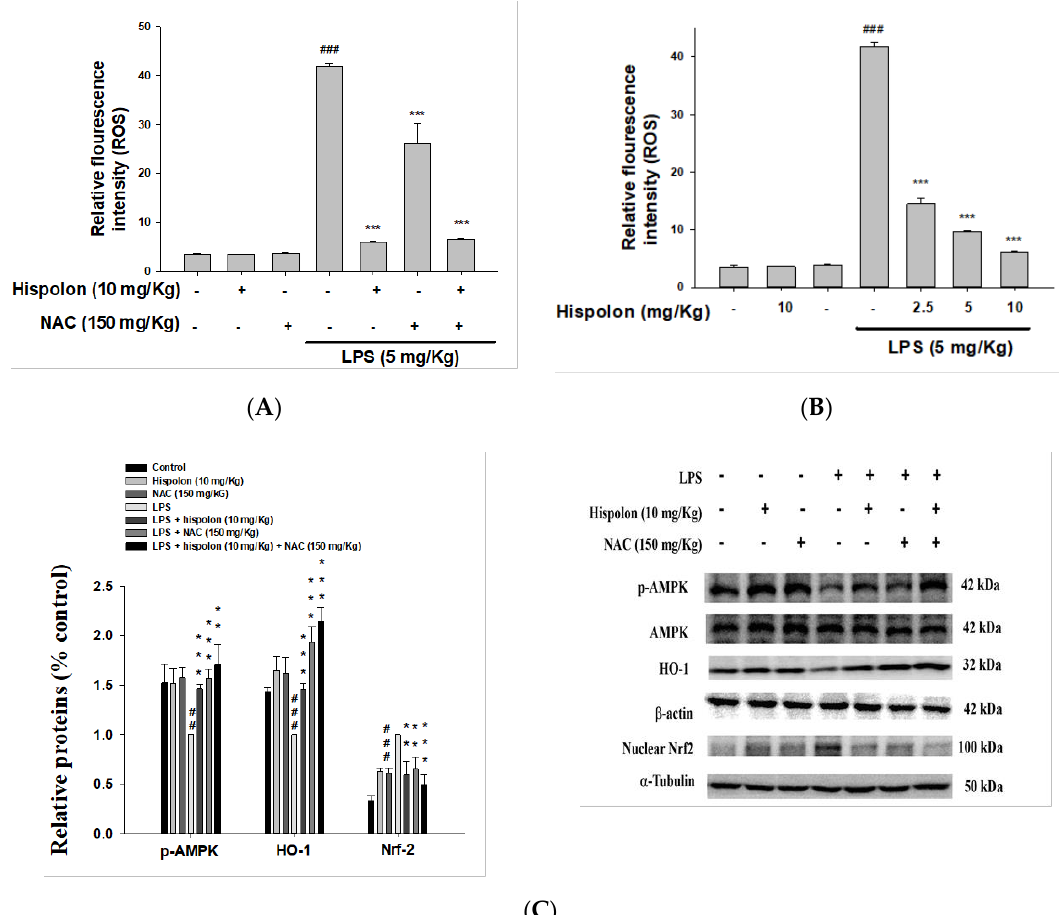
Figure 7. Hispolon downregulated ROS ( A ), a ROS inhibitor (NAC) reduced ROS ( B ) in the BALF and regulated p-AMPK, HO-1 and nuclear Nrf2 ( C ) protein expression in the lungs. ROS was detected after LPS challenge by ELISA. Lung tissue extracts were subjected to Western blot analysis using antibodies for p-AMPK, HO-1 and nuclear Nrf2. Data are represented as means ± S.E.M. (n = 3). ## p < 0.01 and ### p < 0.001 versus the control group. ** p < 0.01 and *** p < 0.001 versus the LPS group.